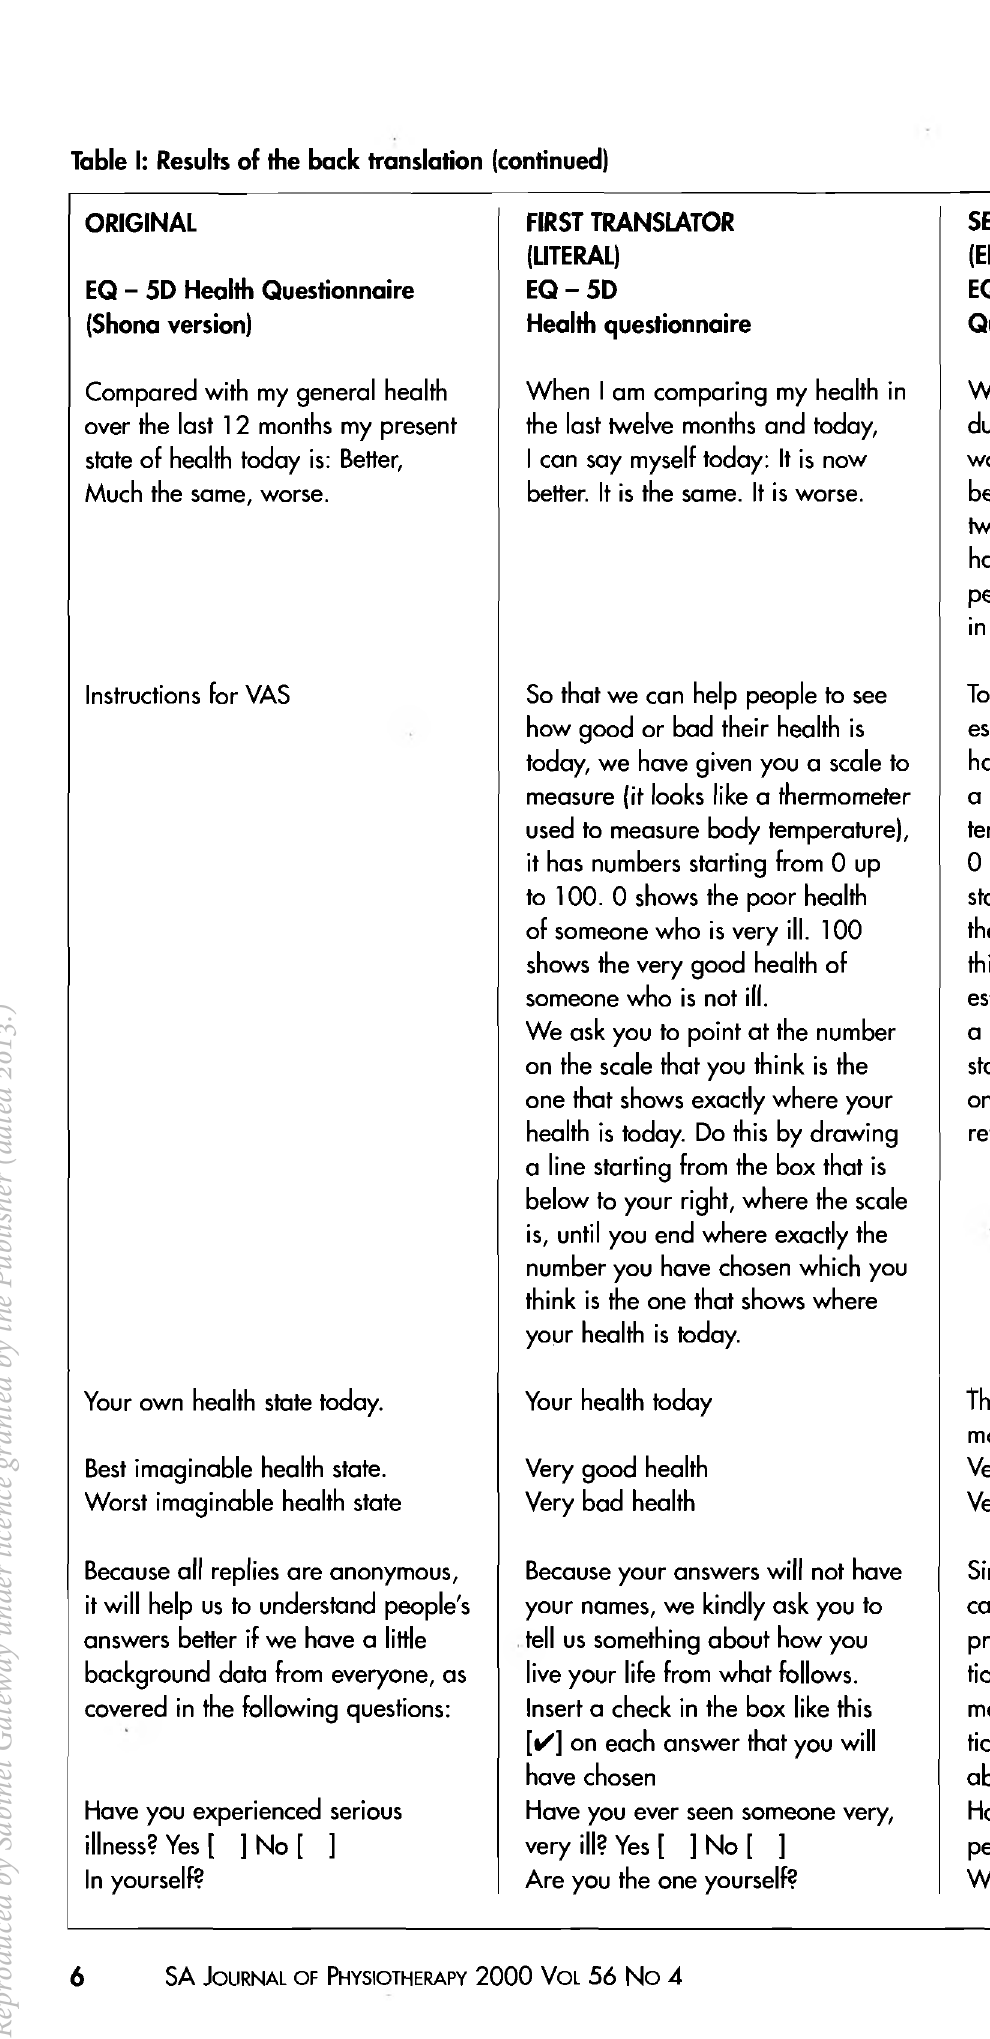
Table I: Results of the back translation (continued) ORIGINAL EQ - 5D Health Questionnaire (Shona version) Compared with my general health over the last 12 months my present state of health today is: Better,